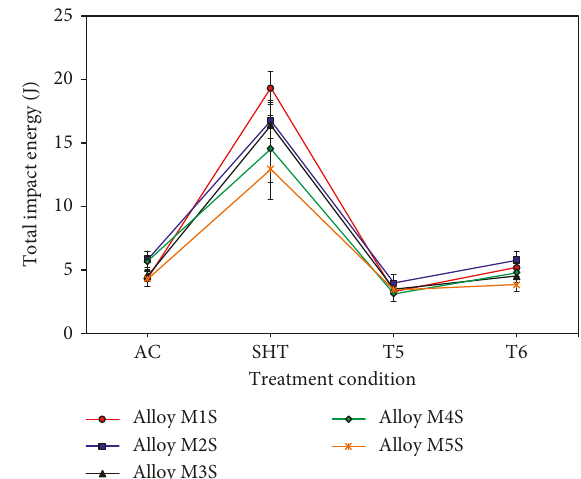
Figure 9: Variation in Rockwell hardness value (HRF) as a func- tion of heat treatment conditions for the alloys studied.